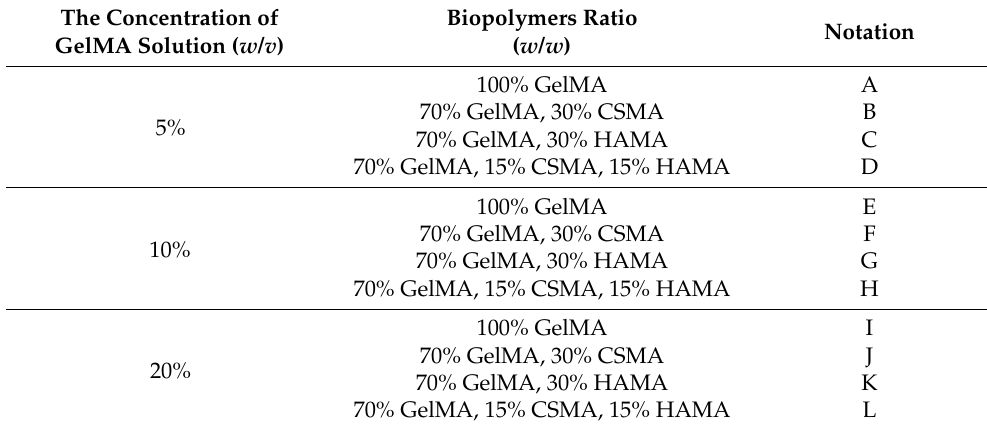
picted in Table 1. The photoinitiator 2-hydroxy-4 (cid:48) -(2-hydroxyethoxy)-2-methylpropiophenone was then added in a concentration of 0.05% ( w / v ). After proper dissolution, 80 µ L aliquots of the resulting solution were placed into silicone mold wells (with 6 mm diameter) and ex- posed to ultraviolet light (366 nm, UV lamp Triwood 6/36; Bresciani srl., Italy, 0.120 J/cm 2 ) at RT for 15 min to promote photocrosslinking [11]. Table 1. Composition and notation of produced GelMA-based hydrogels. The Concentration of Biopolymers Ratio Notation GelMA Solution ( w / v ) ( w / w ) 100% GelMA A 70% GelMA, 30% CSMA B 5% 70% GelMA, 30% HAMA C 70% GelMA, 15% CSMA, 15% HAMA